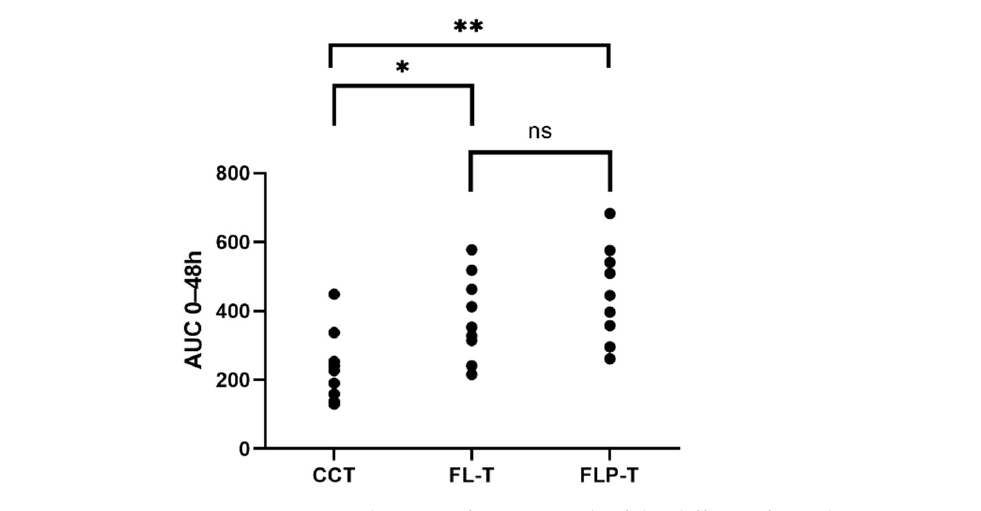
Figure 12. Area under curve from 0 to 48 h of the different formulations, representing the value of each eye. * p < 0.05, ** p < 0.01, ns Non Significant.